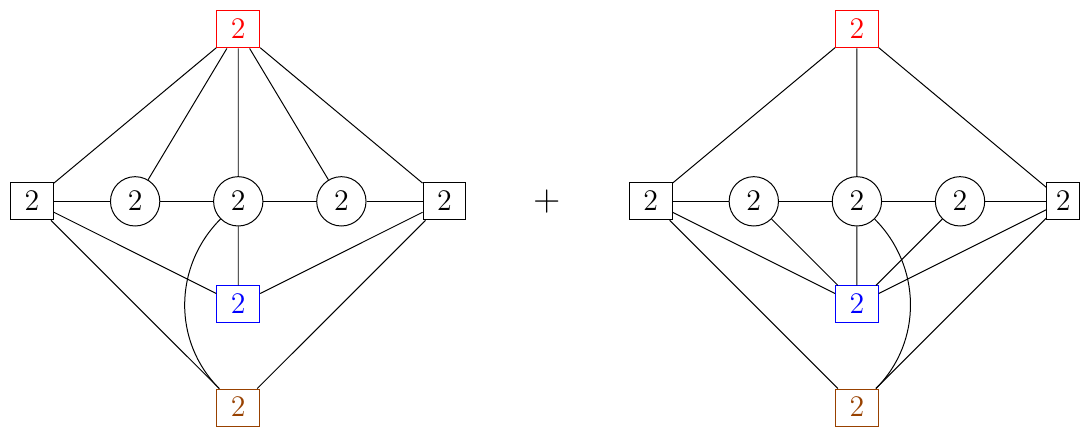
√ 2; 1 , 1 , 0 , 0 , 0 , 0) , on the left,